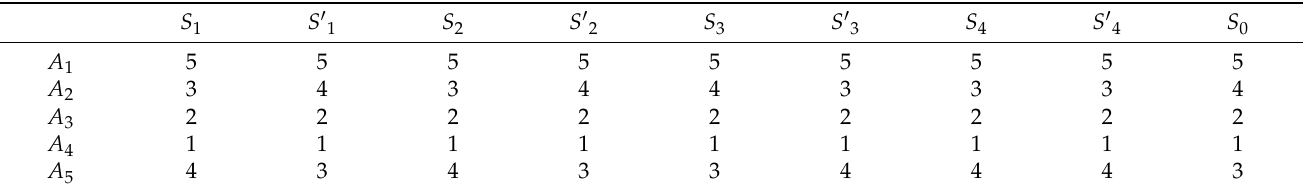
Table 5. Sensitivity analysis in alternative ranking on the basis of fluctuation in the weights of